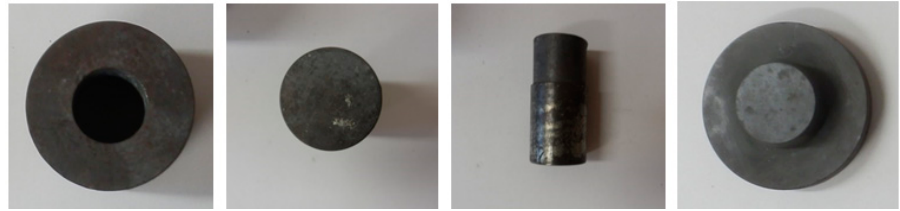
Figure 2. A view of the parts of a steel foundry mould.